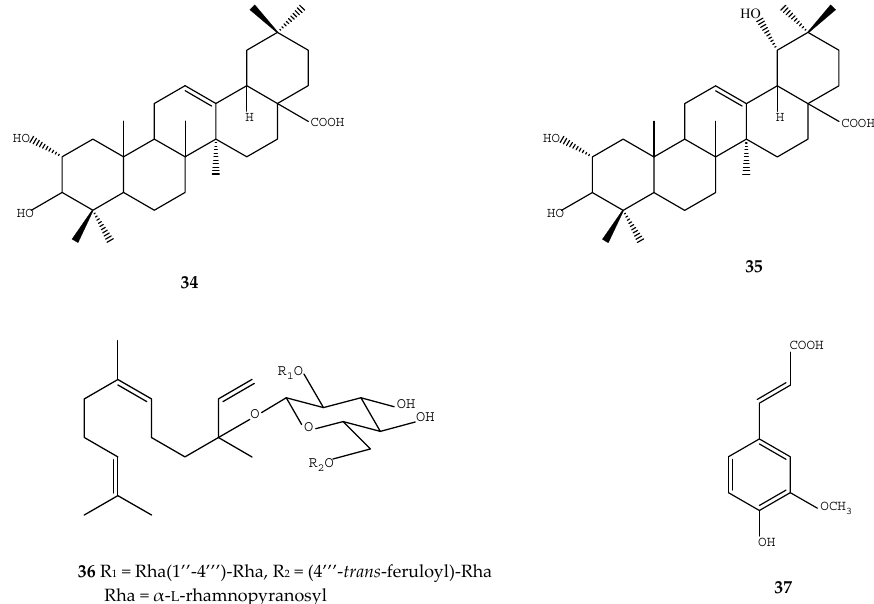
Figure 5. Structures of chemical compounds 34 – 37 . 34 : α -hydroxyoleanolic acid; 35 : arjunic acid; 36 : 3- O - α - L -rhamnopyranosyl-(l → 4)- α - L -rhamnopyranosyl-(1 → 2)-[ α - L -(4- trans -feruloyl)-rhamnopyranosyl- (1 → 6)]- β - D -glucopyranosyl nerolidol; 37 : ferulic acid.